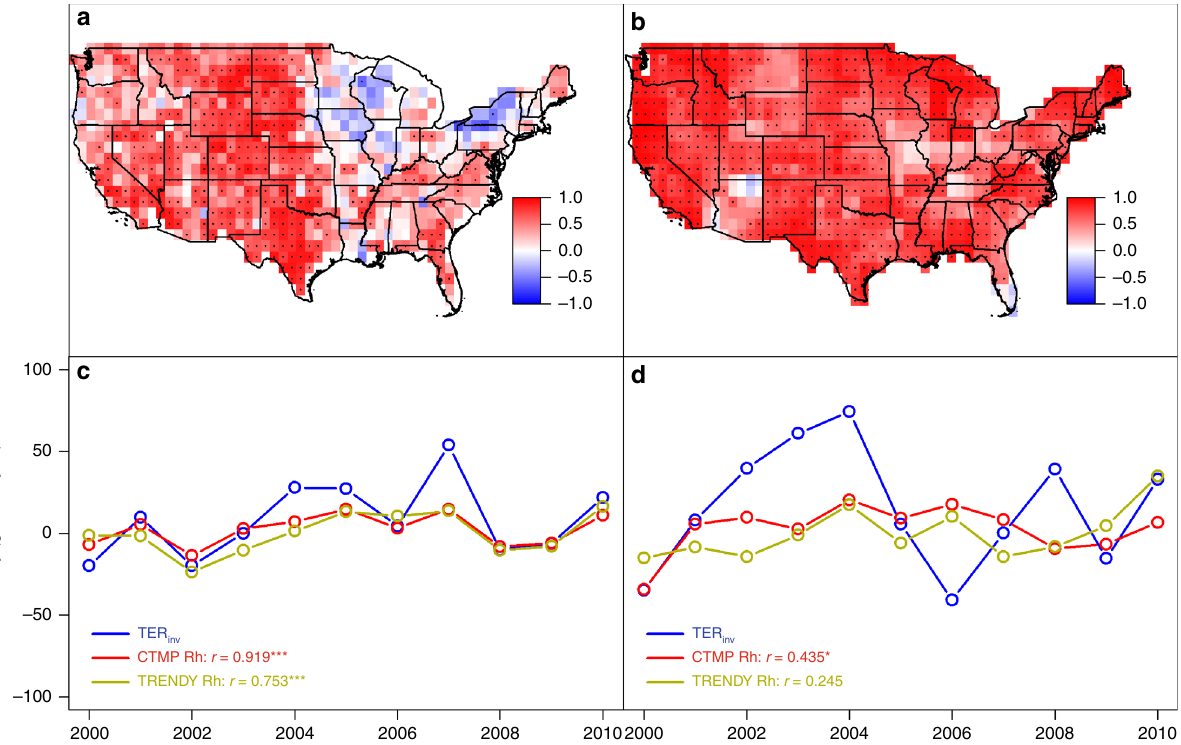
Fig. 4 Temporal correlations between gridded production and respiration. Temporal correlations between gridded GPP and TER with estimates of Rh (heterotrophic respiration) derived from the TER CTMP empirical model. Satellite-derived estimates of GPP (gross primary production) are correlated with Rh predictions from the TER CTMP model ( a ) and TRENDY-derived estimates of GPP are correlated with Rh ( b ), and TER inv anomalies are correlated with TER CTMP Rh, and TRENDY Rh in regions below 750 mm yr − 1 ( c ) and above 750 mm yr − 1 ( d ). The correlation coef fi cients ( r values) in c and d showed the temporal correlation between TER inv anomaly and model Rh anomaly. Symbols *,**,*** indicate signi fi cant level at 0.1, 0.05, and 0.001 levels. a , b were created in the R environment for statistical computing and graphics